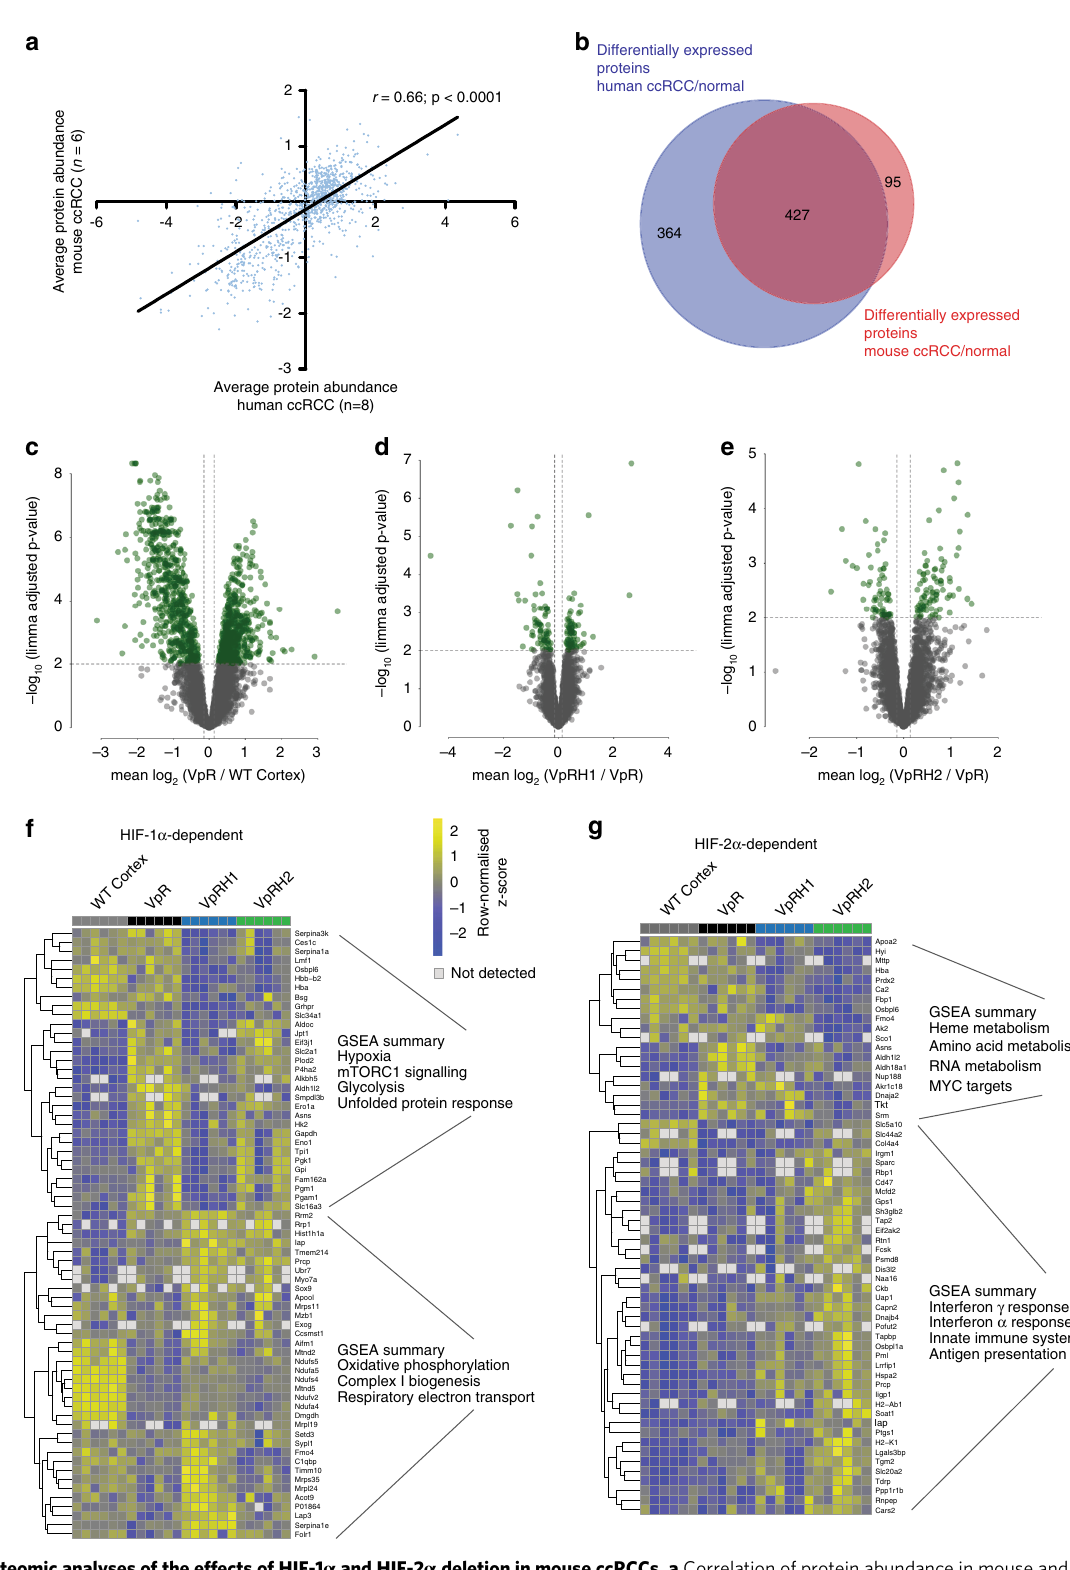
Fig. 4 Proteomic analyses of the effects of HIF-1 α and HIF-2 α deletion in mouse ccRCCs. a Correlation of protein abundance in mouse and human ccRCC samples. Each dot represents a unique pair of orthologous proteins between the two species. Spearmann ’ s correlation coef fi cient is depicted. b Venn diagram showing the overlap of differentially expressed proteins derived from comparison of mouse ccRCC with WT cortex and human ccRCC with normal kidney. Volcano plots showing differentially expressed proteins (green dots) between VpR and WT cortex ( c ), VpRH1 and VpR ( d ), and VpRH2 and VpR ( e ). Protein expression heatmaps showing differentially expressed proteins between VpRH1 and VpR ( f ) and VpRH2 and VpR ( g ) as well as a summary of GSEA terms associated with the down- and upregulated proteins. Rows represent row-normalised z -scores of protein abundance, each column represents an individual sample from WT cortex or VpR, VpRH1, and VpRH2 tumours. Source data is provided in Supplementary Data